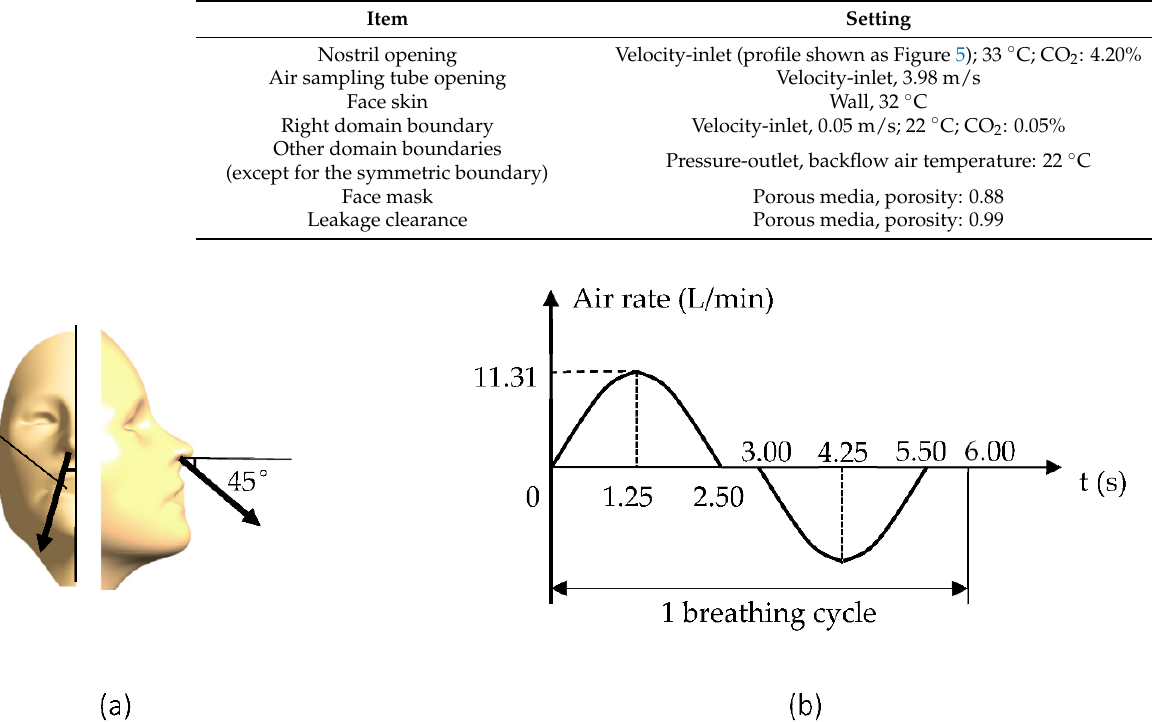
Figure 5. The boundary condition for dynamic respiratory flow: ( a ) exhaled air directions, ( b ) respiratory flow rate profile. Table 1. Boundary conditions in CFD modeling.